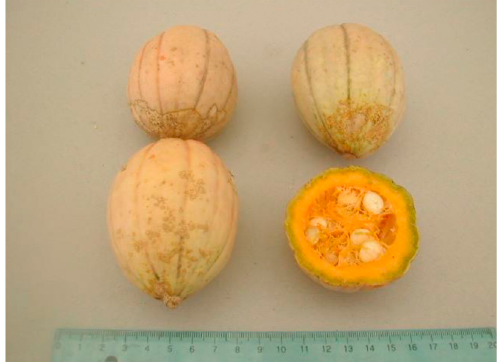
Figure 16. Mature entire and sliced fruits of Ovo de Ganso (MAX 24, IPK Genebank, Gatersleben, Germany). Blue ruler length 20 cm.